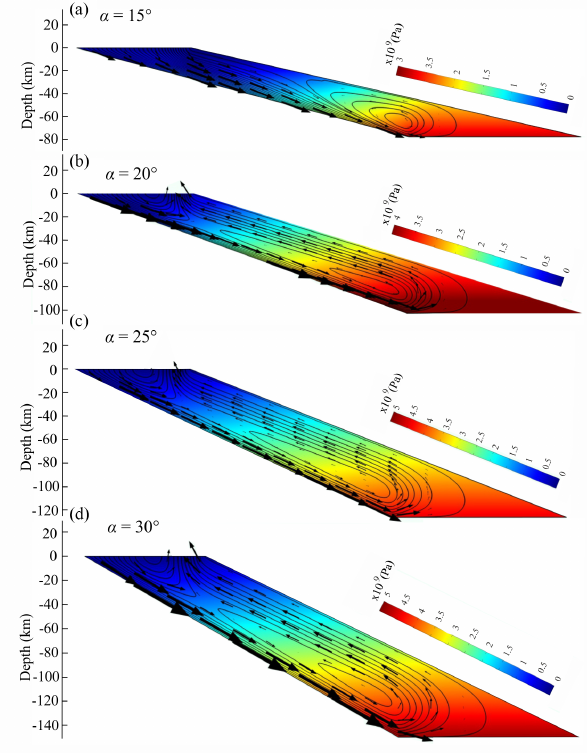
Figure 5. Simulations showing the effects of channel dip ( α ) on flow pattern, keeping W m = 100km, W b = 150km, U = 4cmyr − 1 , and viscosity = 10 21